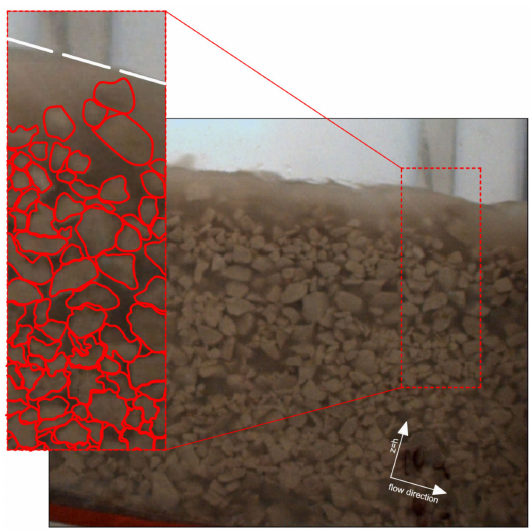
Figure 4. Variation of grains concentration in the depth of flow and particular of the grain configuration. The values of grain concentration C obtained for all the sub-layers were plotted against the distance from the upper level of the static bed, as reported in Figure 5.